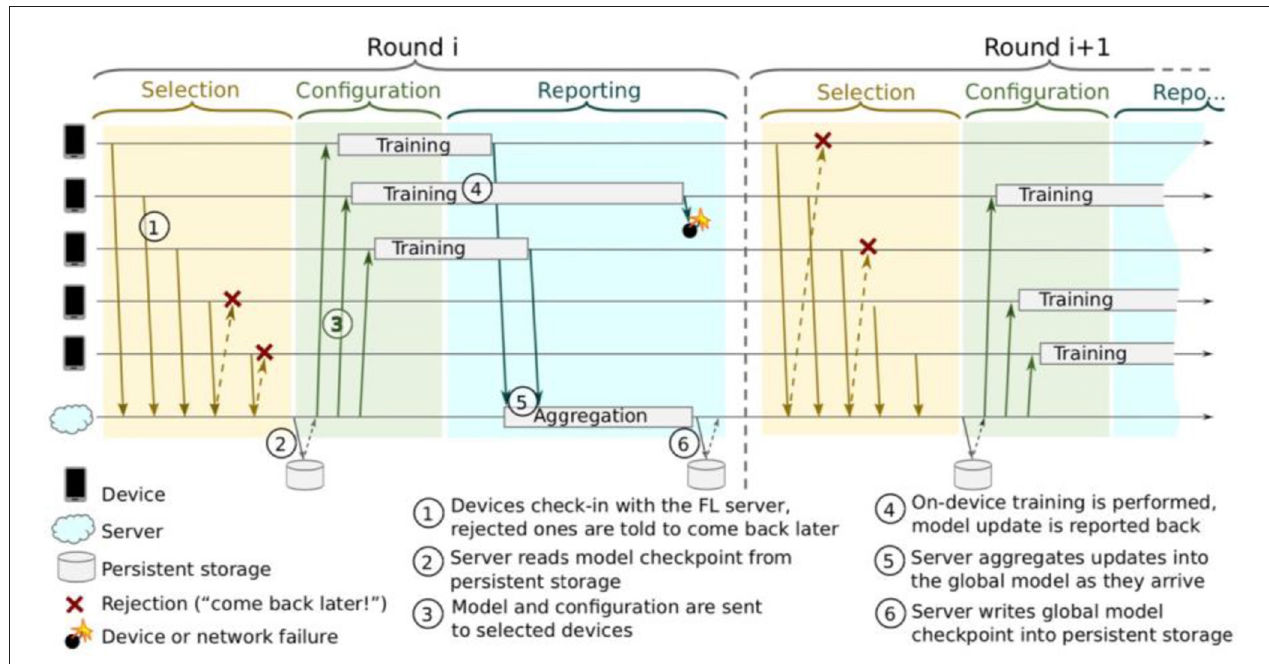
FIGURE 3 | Federated Learning protocol (Bonawitz et al.,